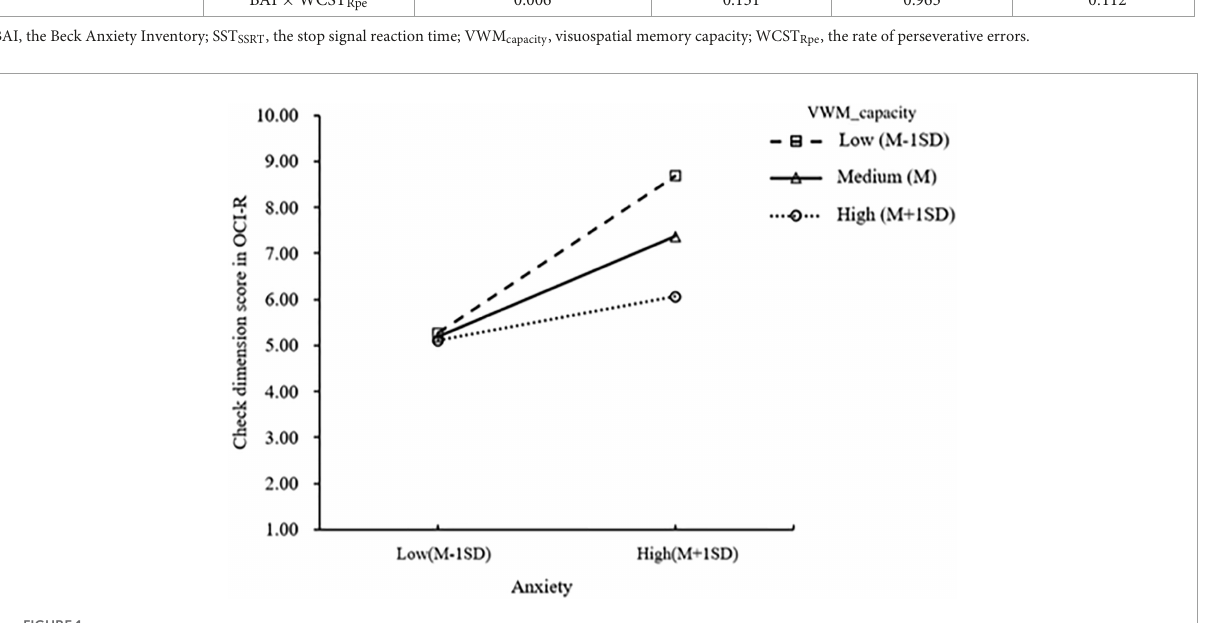
FIGURE1 Simple slope test of visuospatial memory capacity (VWM capacity